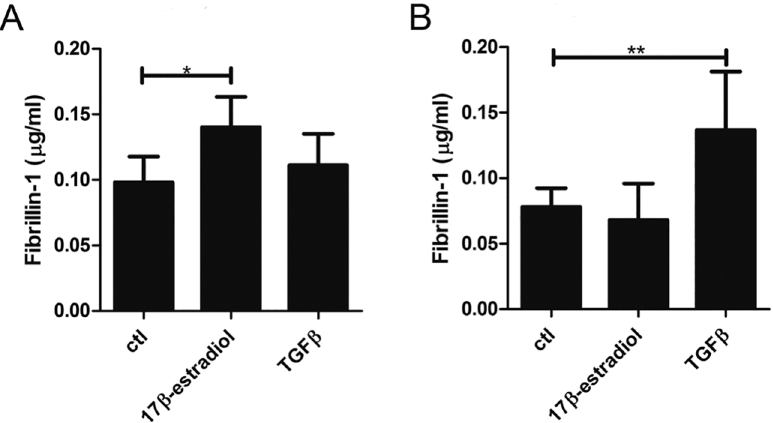
Fig 4. Fibrillin-1 production by (A) human aortic smooth muscle cells (HASMC) and (B) fibroblasts. Cells were treated with 17 β - estradiol and TGF β -1 and comparedto untreated control cells. Higher concentrations of 17 β -estradiol(4–8 nmol/L) compared to control (ctl) (0, 1 or 2 nmol/L 17 β -estradiol) promotedfibrillin-1production by HASMC. In contrast, fibrillin-1productionby fibroblasts was stimulated by TGF β -1 but not by 17 β -estradiol. Results shown were obtainedusing the antibody pair B15-AP201. Error bars (standard deviation)are based on combiningtwo separateexperiments with HASMC and three separate experiments with fibroblasts. In each experiment, samples were tested in duplicate. Significantp-values are marked with an * .